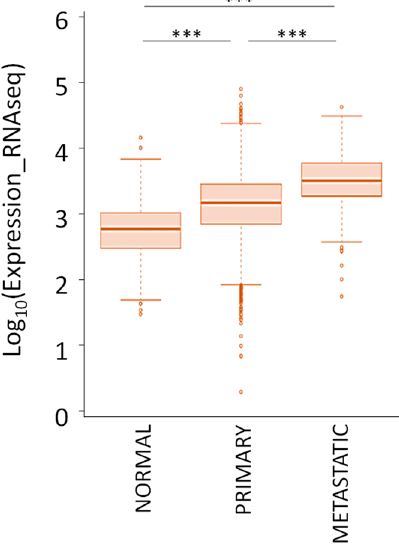
Figure 8. TRIB3 mRNA expression in normal and tumor tissues from 33 different cancer types